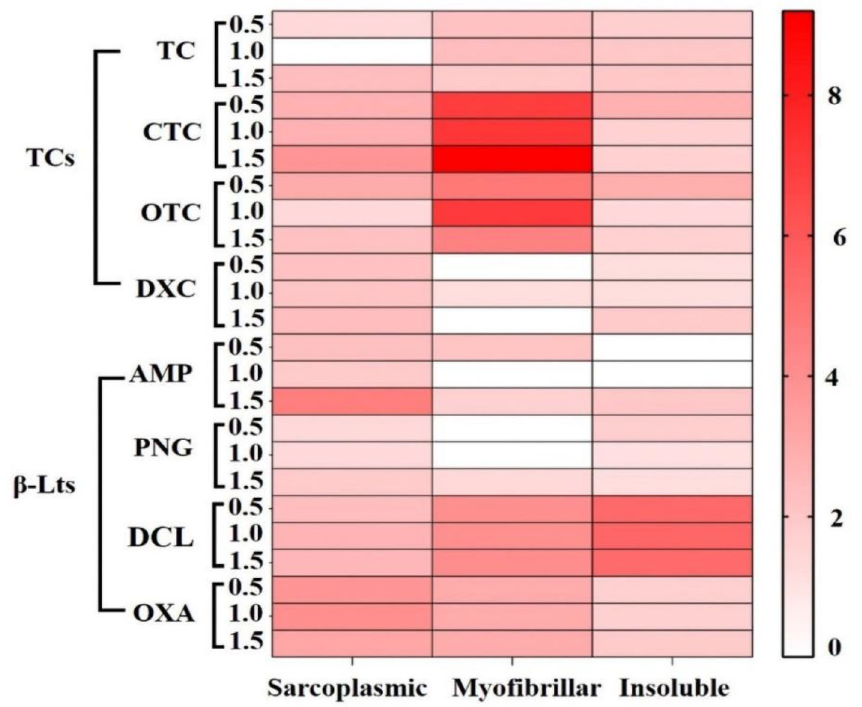
Figure 4. Heat map with average values of the oxidant power (ratios) induced by the evaluated TCs and β -LTs. The results of the comparative analysis between the carbonylation induced by TCs and β -Lts according to the type of fraction is described in the first item (Figure 1). On the other hand, the medians of the carbonylation indices (CIs) promoted by the two groups of antibiotics evaluated through the Mann-Whitney test were compared; results showed that there were no significant differences between the CIs in the samples exposed to both groups of antibiotics ( p = 0.3714), Figure 5.